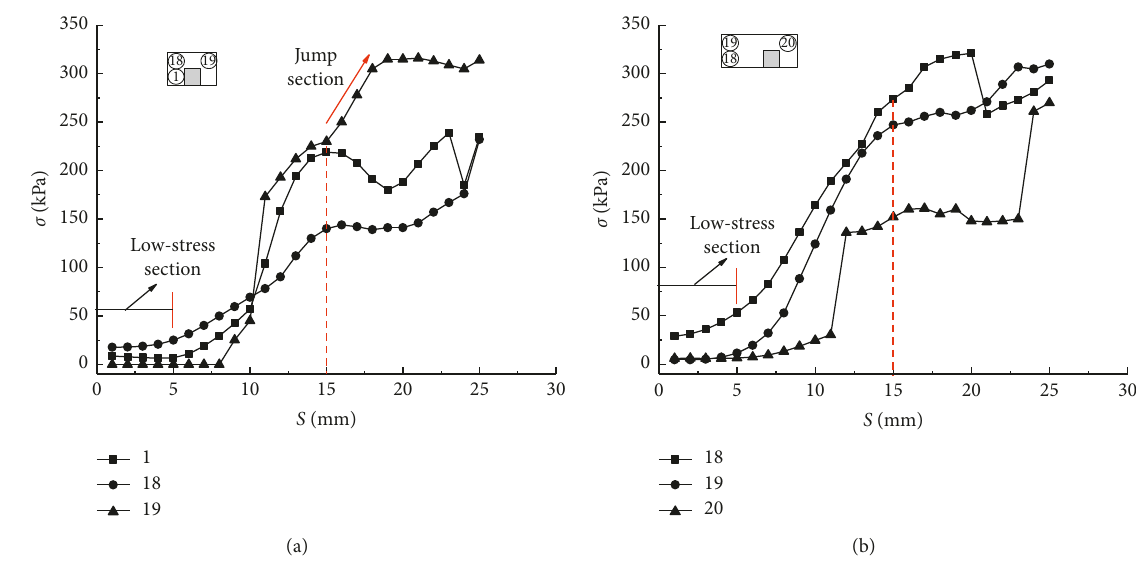
Figure 18: Sand vertical stress distribution beneath the cap. (a) 3 b pile spacing. (b) 6 b pile spacing.